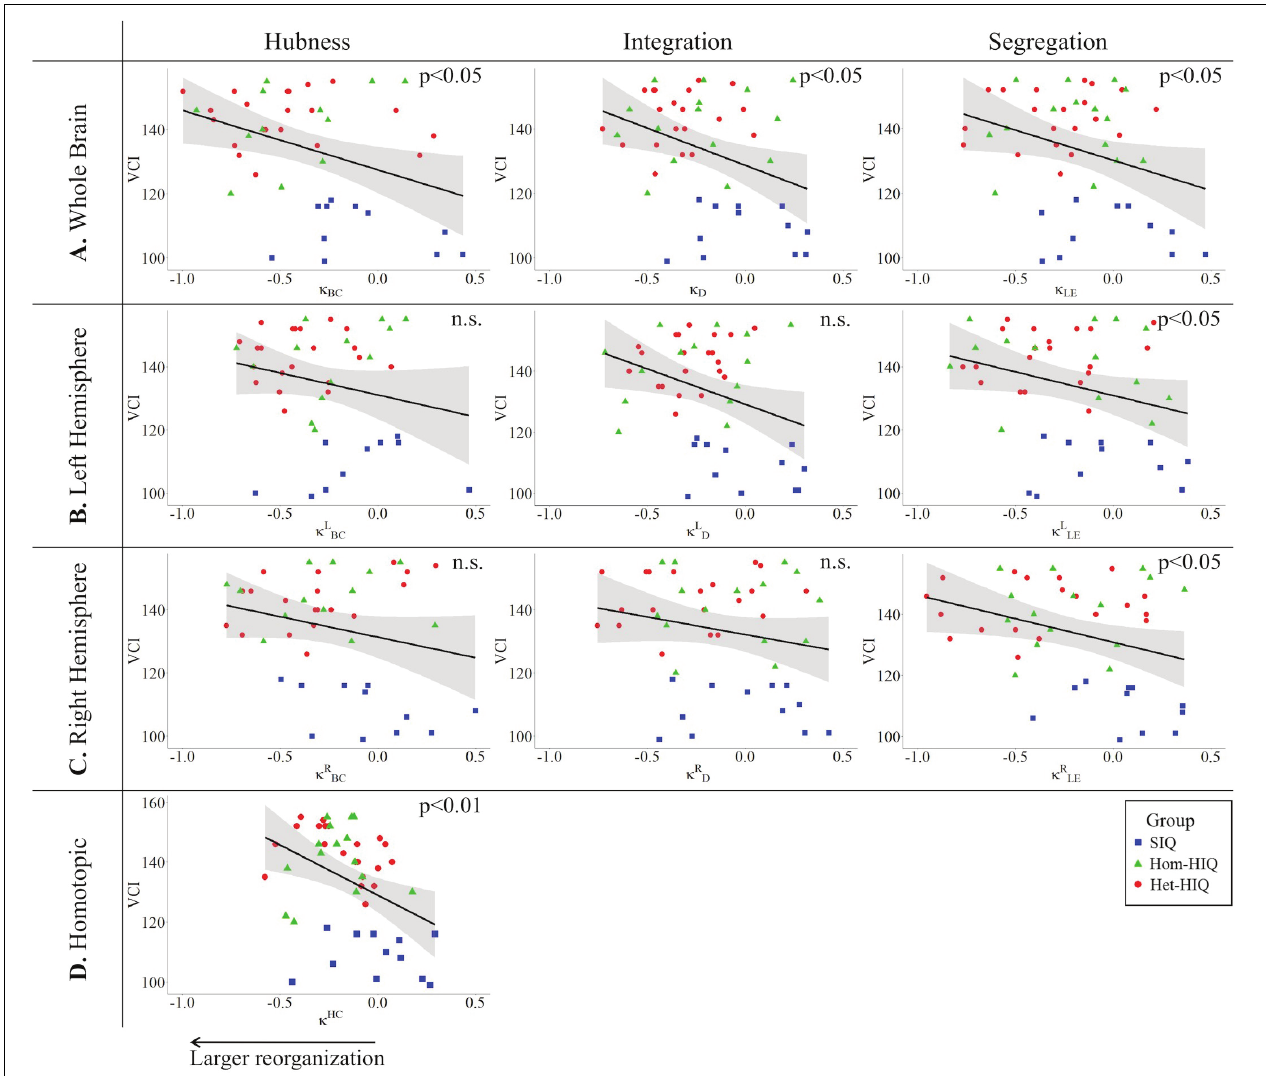
FIGURE 3 | Correlations between verbal comprehension index (VCI) and hub disruption indices ( κ ) of graph metrics measured in: (A) the whole brain networks, (B) the left hemisphere networks, (C) the right hemisphere networks, and (D) the homotopical nodes. Significant correlations were measured for κ describing hubs properties in the whole brain networks ( κ BC ), for integration properties in the whole brain networks ( κ D ), and for segregation properties in the whole brain networks ( κ CC and κ LE ), in the left ( κ L CC and κ L LE ) and right hemisphere ( κ R CC , κ R LE ), and for homotopic connectivity ( κ HC